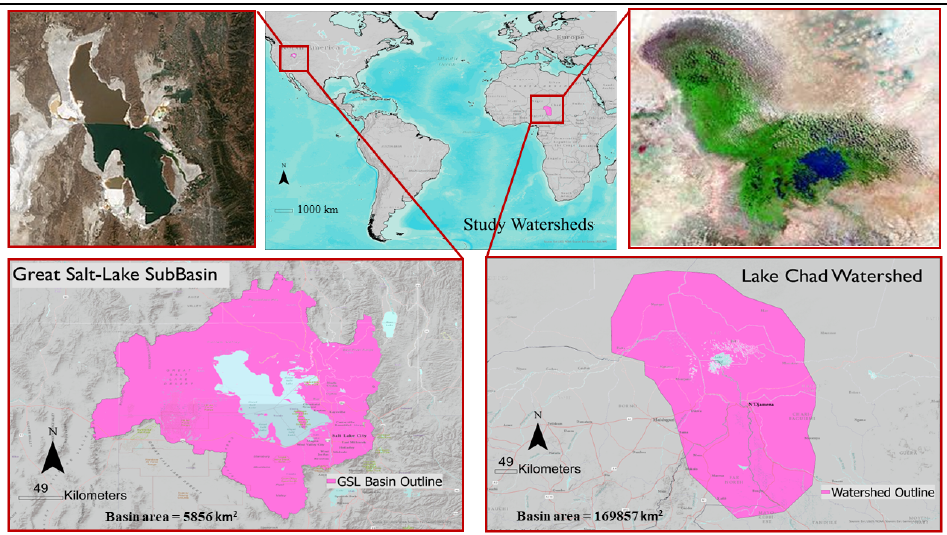
Figure 1. Geographical location of the study areas. The left insert represents the Great Salt Lake Sub- basin and the satellite image of GSL at its current state. The right insert map shows the digitized boundary of the Lake Chad watershed and the satellite image of Lake Chad in its current